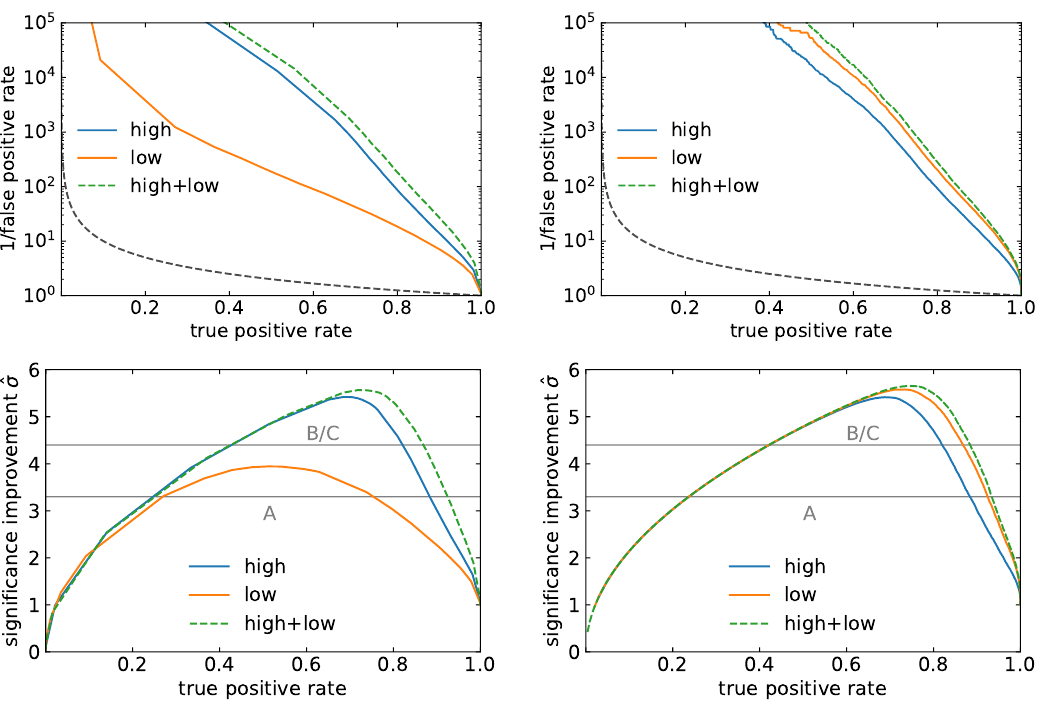
Figure 5 . ROC (top) and SIC curves (bottom) for BDT (left) and BNN (right) for different levels of input features, trained and tested on E VT G EN data with a physical ratio of signal-to-background events in the test set. The dashed lines in the upper panel are ROC curves for the case of no separation. As a reference, the gray lines in the bottom panel show the significance improvement from the three cut-and-count scenarios in eq. (3.7). A: M